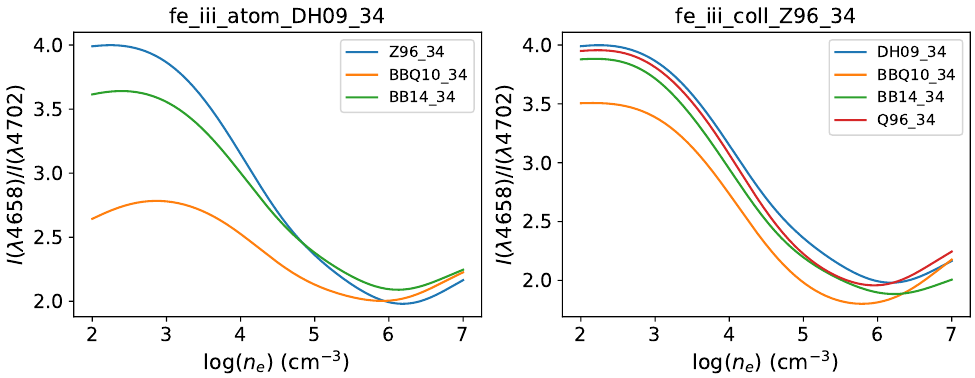
Figure 1. Density behavior of the [Fe III ] I ( λ 4658 ) / I ( λ 4702 ) emissivity ratio at T e = 7.9 × 10 3 K for different atomic datasets. Left panel : atom_DH09_34 dataset with three coll datasets ( Z96_34, BBQ10_34, and BB14_34). Right panel : coll_Z96_34 dataset with four atom datasets (DH09_34, BBQ10_34, BB14_34, and